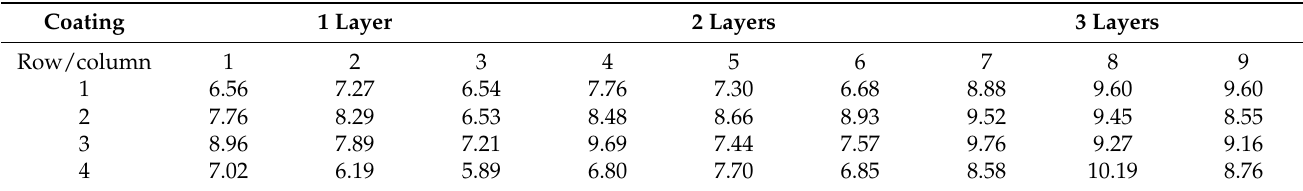
Table 3. Comparison of logarithms of the impedance moduli | Z 0.1 | ( Ω cm 2 ) at 36 test points on the large steel sheet with the blue coating at a measurement frequency of 0.1 Hz.